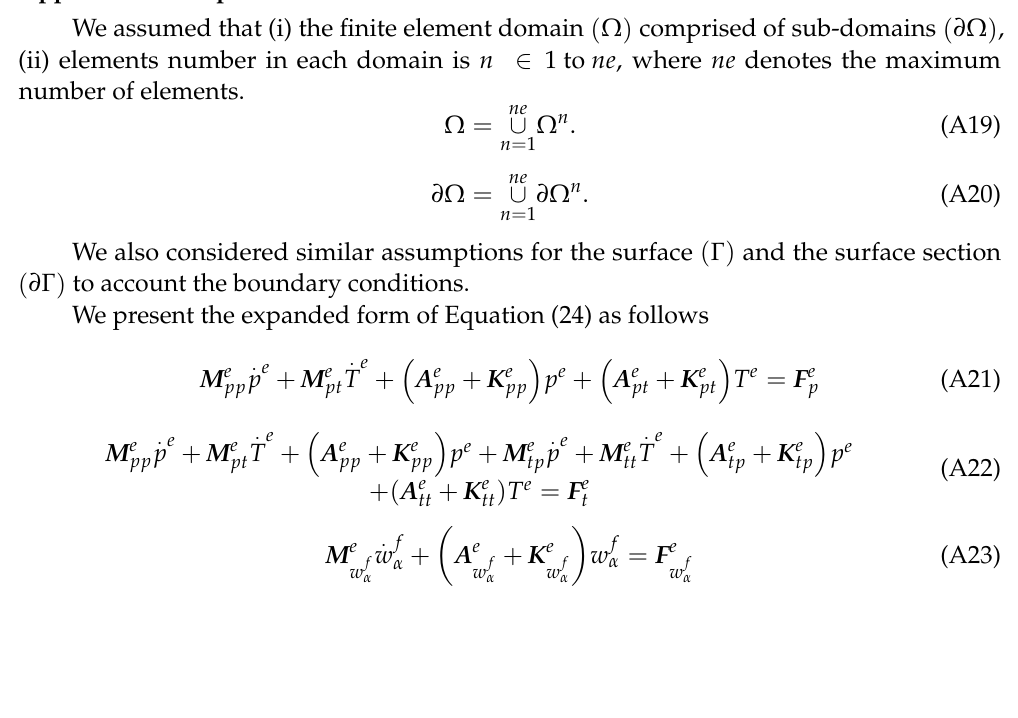
Figure A2. Properties of H 2 O at 307.15 K ( a – g ; see also CoolProp Package: Bell, Wronski, Quoilin and Lemort [57]).